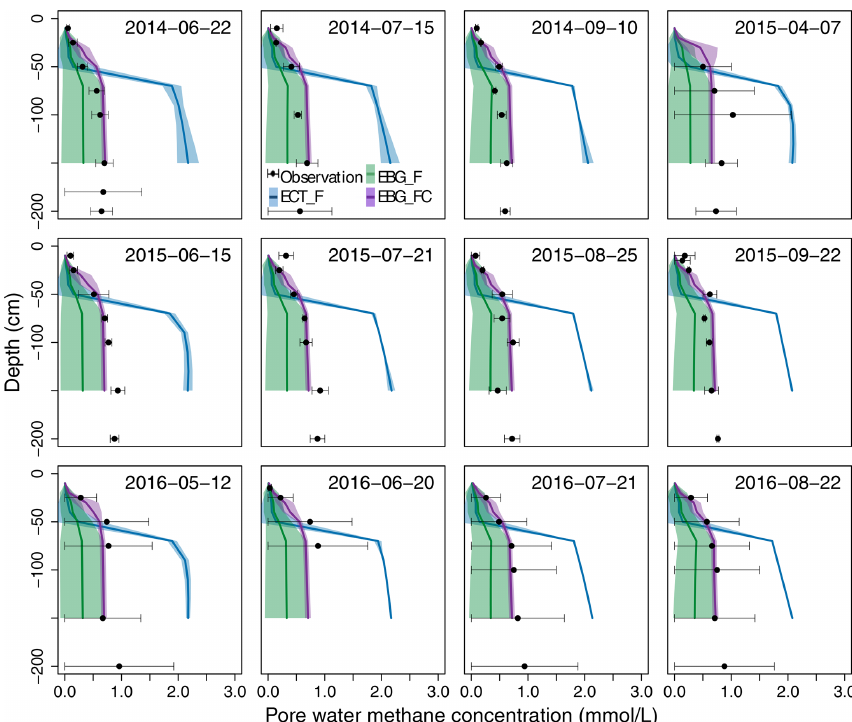
Figure 4. Observed versus simulated pore water CH 4 concentration profiles. Black dots are observed concentrations measured from piezome- ter samples. Blue lines are the ECT-model-simulated concentrations based on the parameter probability distributions (PPDs) constrained by CH 4 flux data (ECT_F). Green lines are the EBG-model-simulated concentrations based on the PPDs constrained by CH 4 flux data (EBG_F). Purple lines are the EBG-model-simulated concentrations based on the PPDs constrained by both CH 4 flux and concentration data (EBG_FC). All mid-lines and shaded areas correspond to the means and standard deviations, respectively, from 500 model simulations with parameters randomly drawn from the posterior